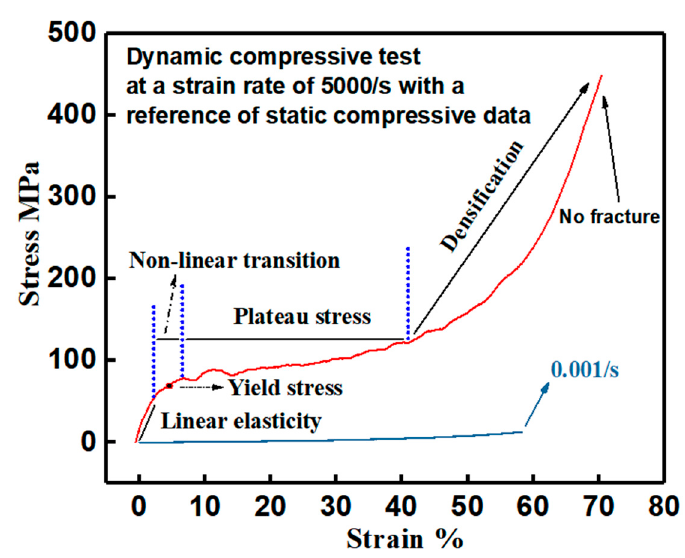
Figure 4. Representative engineering stress–strain curve of the developed PUE material at a strain rate of 5000/s with a reference curve showing the static compressive data at a strain rate of 0.001/s.